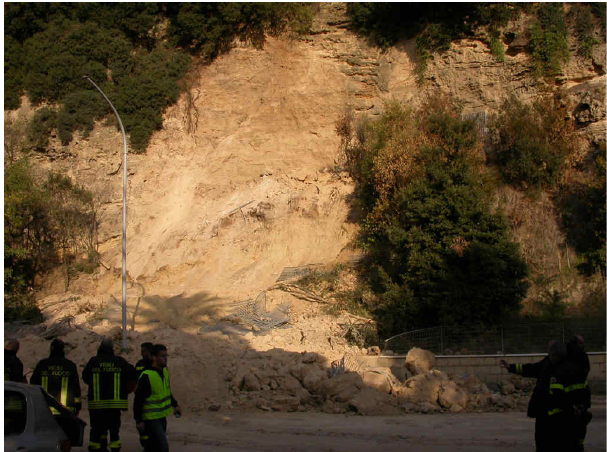
Fig. 1. View of the rock-fall area during the fire department squad’s intervention.